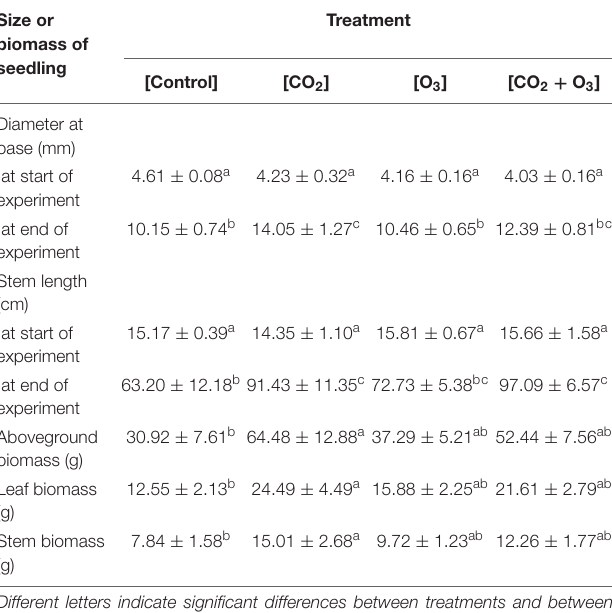
TABLE 1 | Size and biomass (mean ± standard deviation) of Q. mongolica seedlings at the start and end of the experiment, after treatments of atmospheric CO 2 and O 3 concentration ([Control]), elevated CO 2 concentration ([CO 2 ]), elevated O 3 concentration ([O 3 ]), and a combination of elevated CO 2 and O 3 concentrations ([CO 2 + O 3 ]).